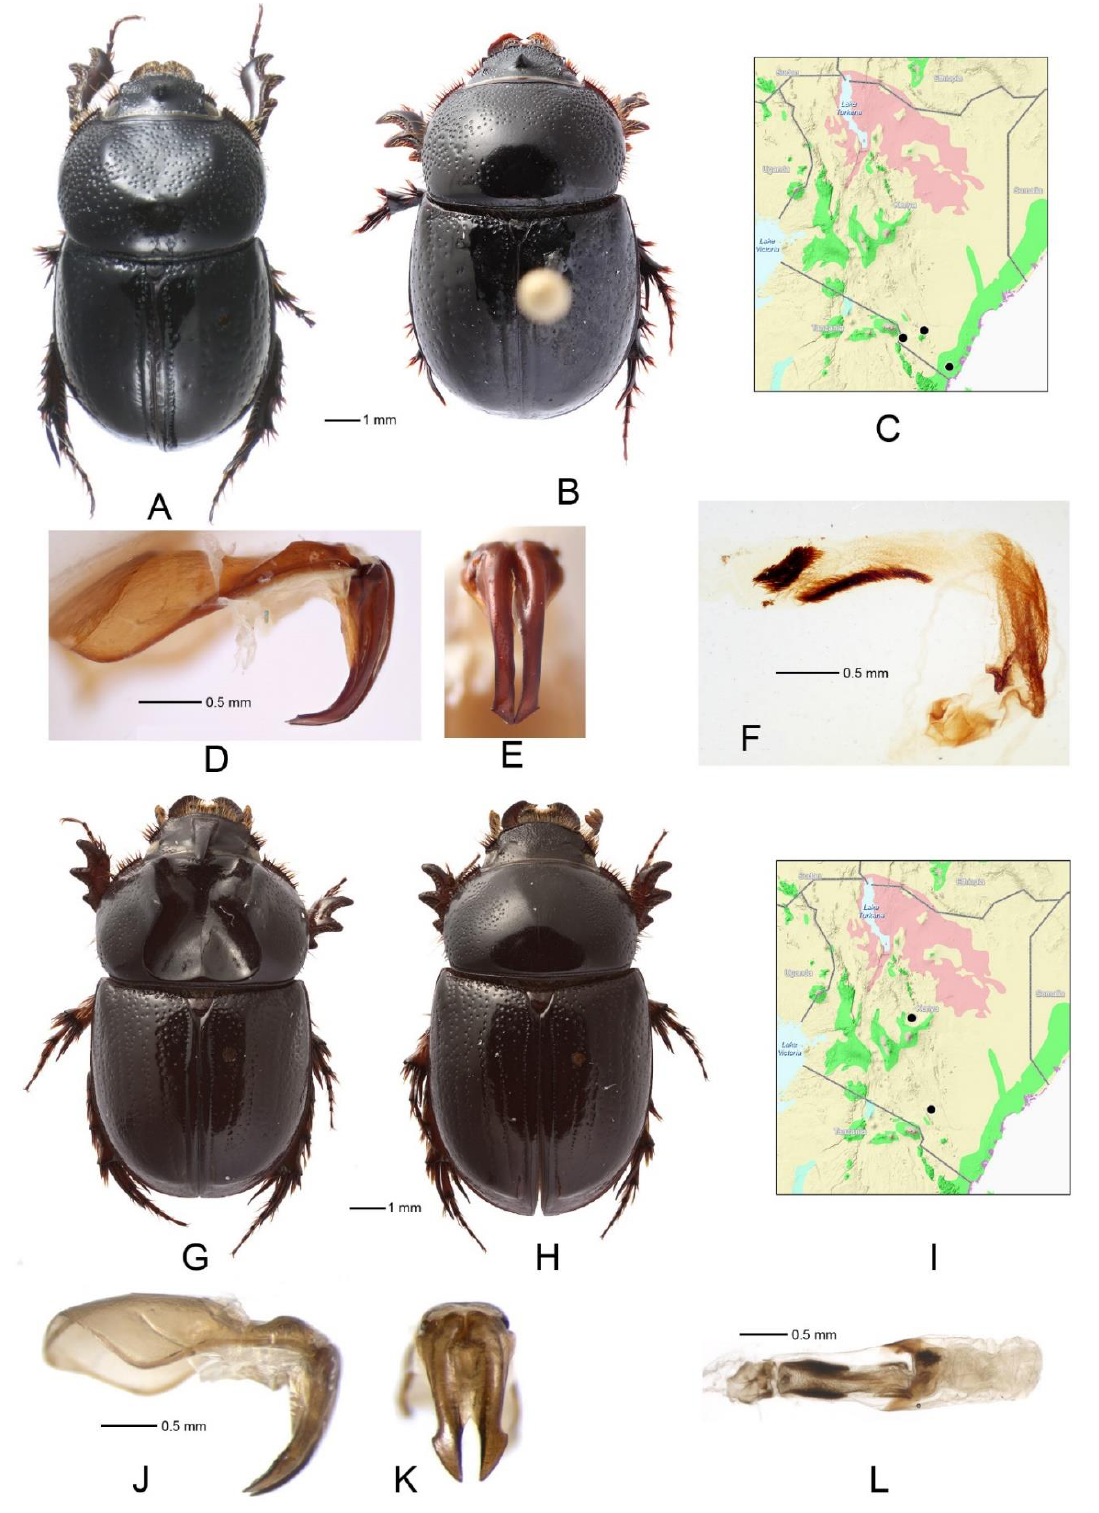
Figure 6. Orphnus compactus Petrovitz, 1971 ( A – F ) and O. compactilis Quedenfeldt, 1884 ( G – L ). ( A , G ) male, habitus; ( B , H ) female, habitus; ( D , J ) aedeagus in lateral view; ( E , K ) parameres in dorsal view; ( F , L ) endophallus; ( C , I ) distributional record map.